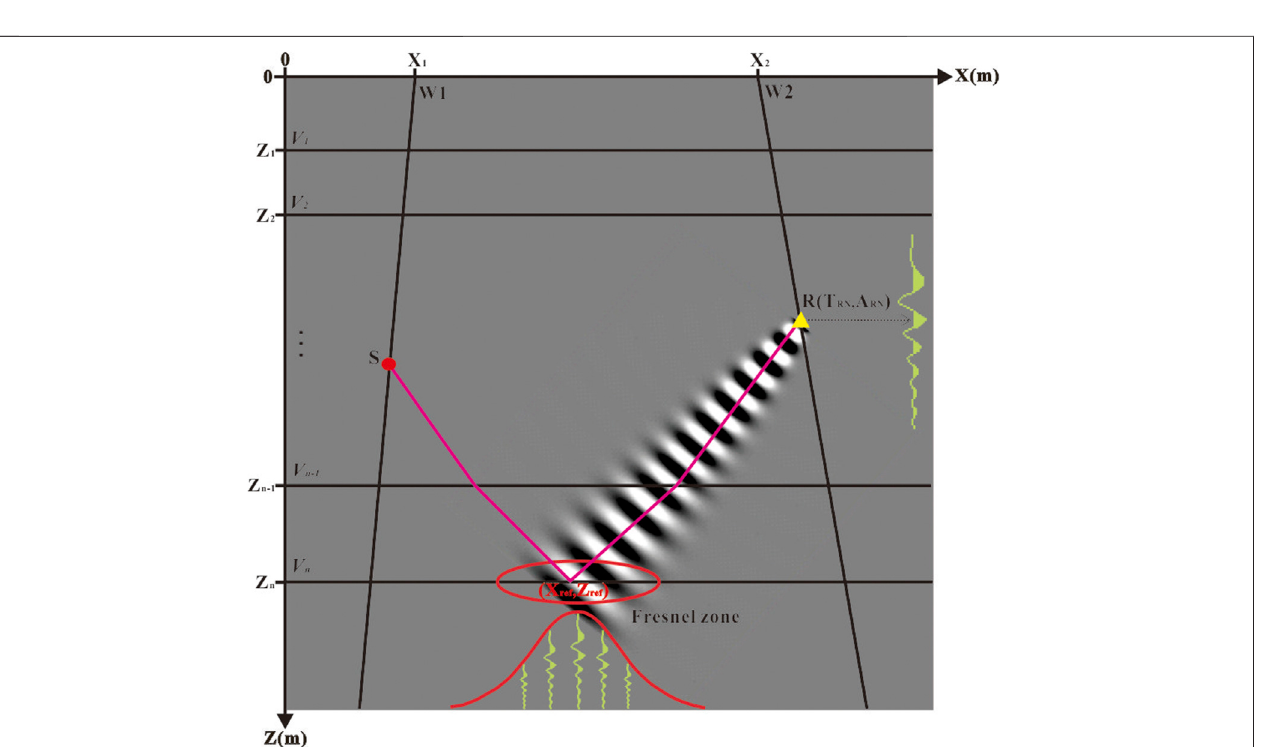
FIGURE 3 | Schematic diagram of inverse Fresnel beam XSP-CDP wave fi eld conversion.